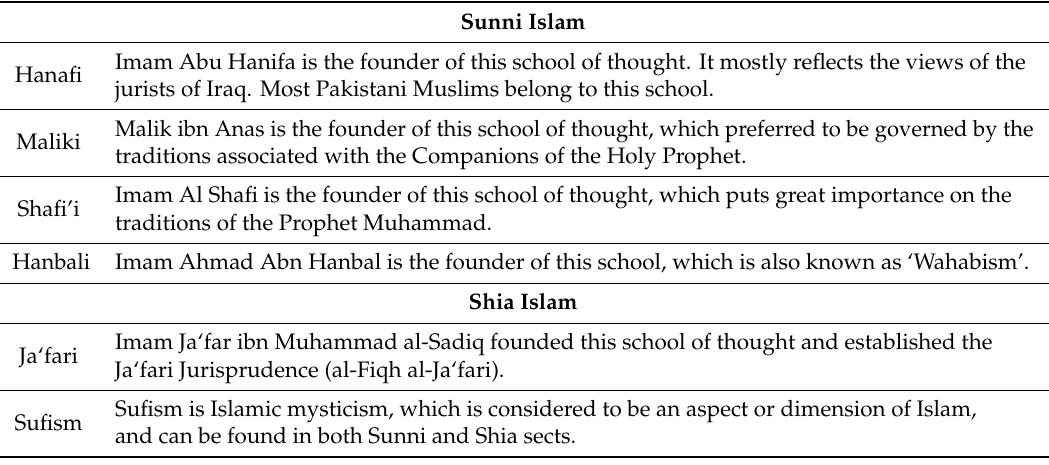
Table 1. Di ff erent schools of thought in Sunni and Shia Islam.